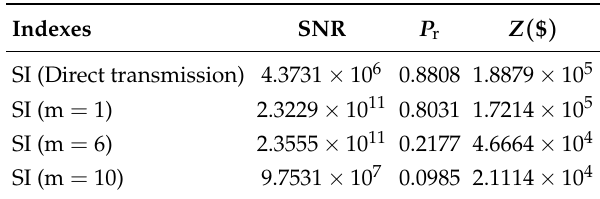
Figure 6. The costs to utility company under the transmission modes. Table 2. Comparison results.